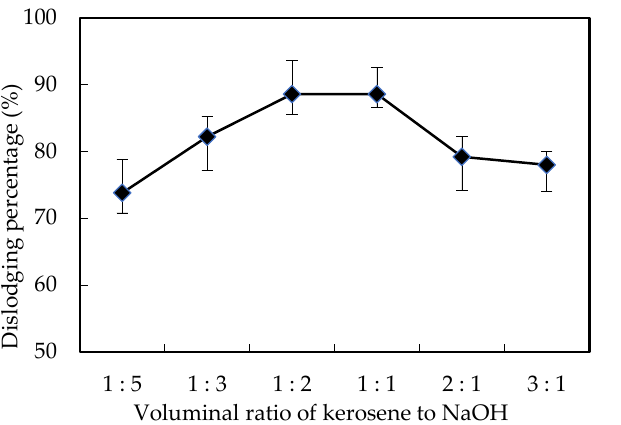
Figure 4. Effects of the voluminal ratio of petroleum to sodium hydroxide on the dislodging efficiency of Cr (VI).